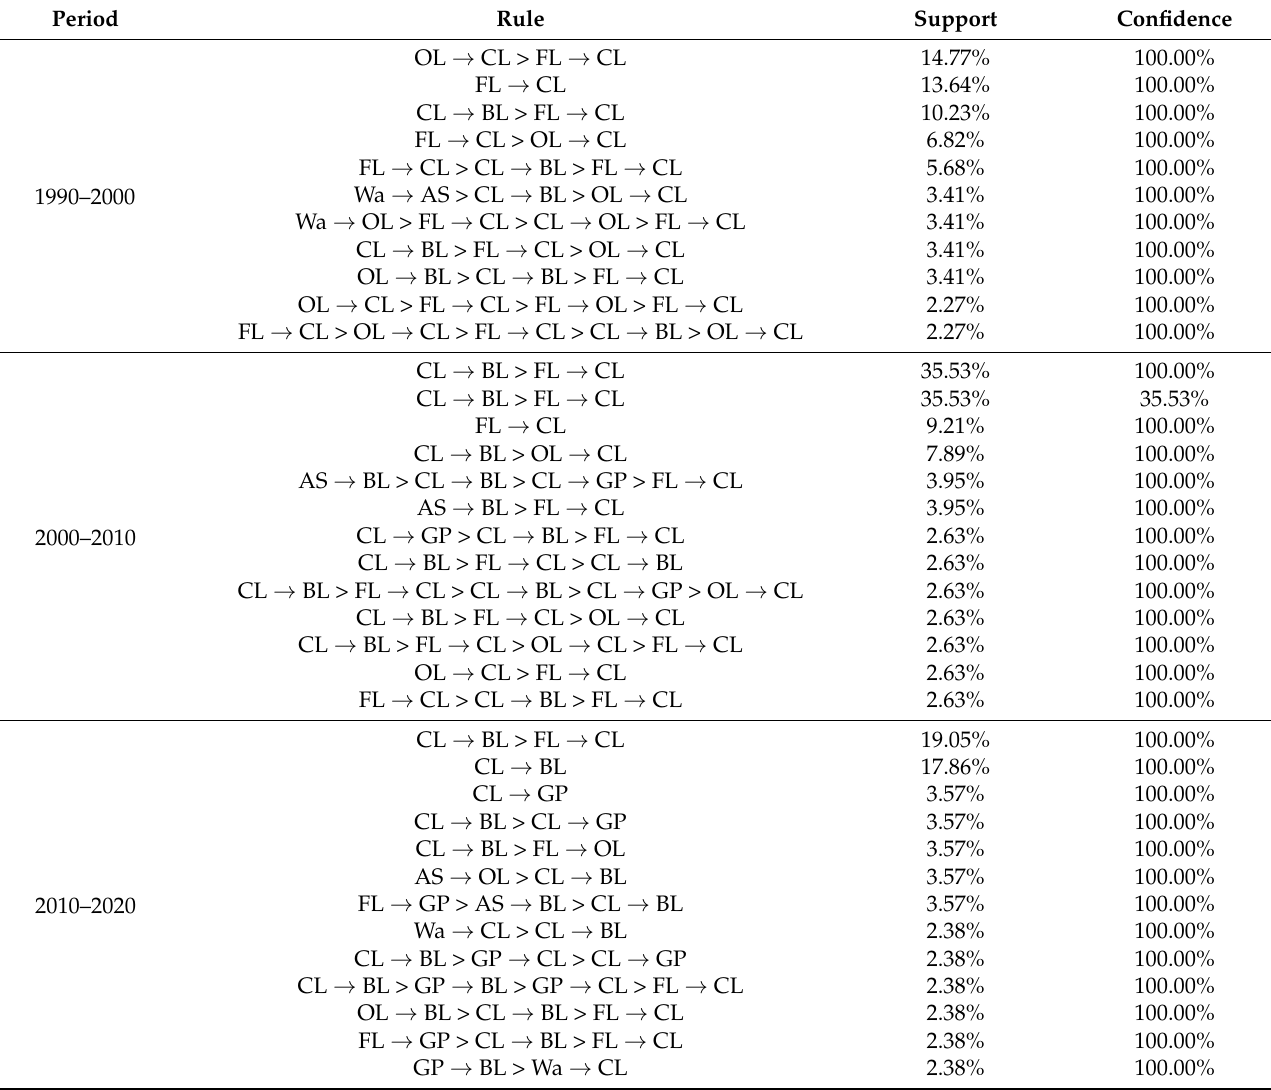
Table 6. LUT association rules in the Yantai